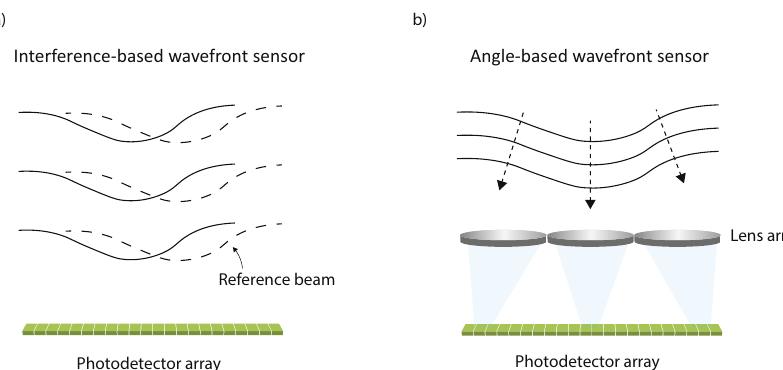
Fig. 1 Two different types of wavefront sensing. a Interference between the incident wave and a reference wave produces intensity modulation that can be recorded by photodetector arrays. The reference wave can often be generated from the same incident wave. Multiple interference patterns are usually needed in order to retrieve the wavefront without ambiguity. b Arrays of micro-lenses are used to measure the spatial distribution of incident angles on the wavefront. The size of lenses is usually much larger than the optical wavelength in order to have a good